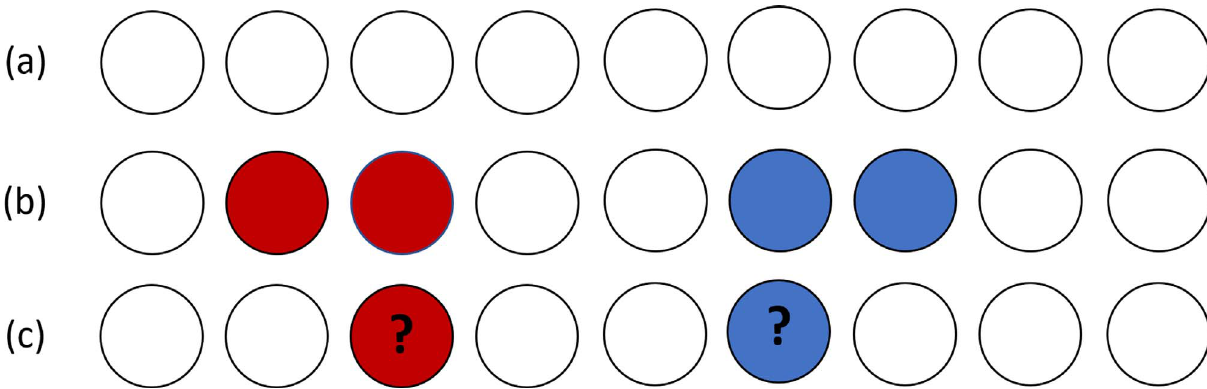
Figure 3. (a) Nine particles are drawn from a probability distribution p , corresponding to a pure state, but they are not yet observed. (b) We look at particles 2 – 3, which turn out to be both red, and then look at particles 6 – 7, which turn out to be both blue. (c) Had we drawn particles 3 – 6, we would have expected them to be of same color, but this is in contradiction with the “ experiment ” of row